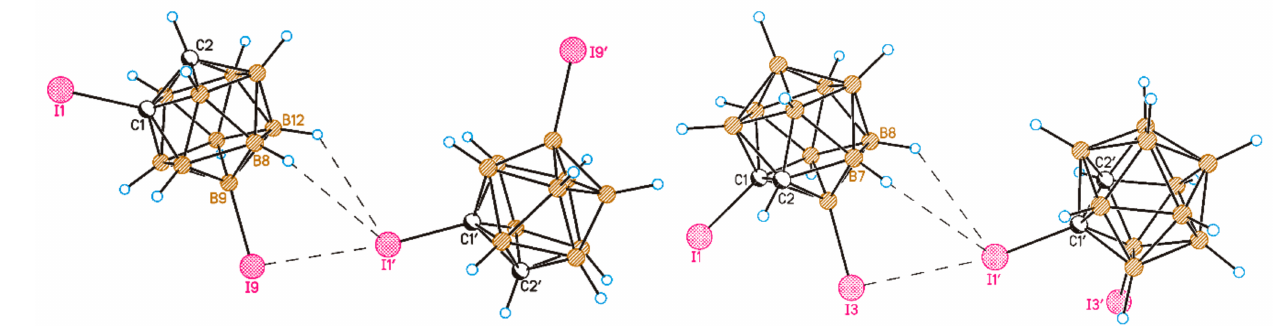
Figure 4. Noncovalent bonding in dimers of 1,9-I 2 -1,2-C 2 B 10 H 10 ( left ) and 1,3-I 2 -1,2-C 2 B 10 H 10 ( right ). Table 2. Characteristics of intermolecular noncovalent interactions for halogen-bonded dimers